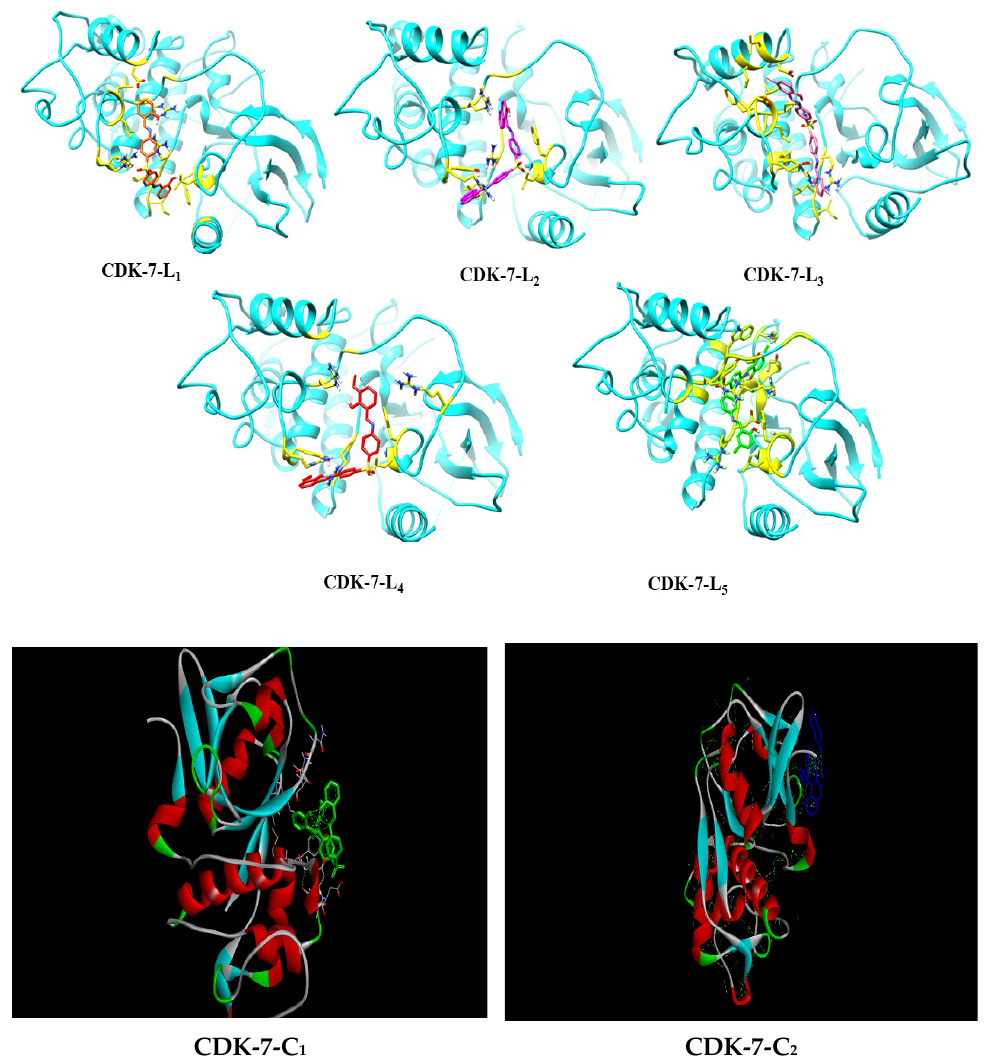
Figure 6. Binding interaction of Schiff base ligands (L 1 -L 5 ) (top) and Co(II) complexes (C 1 –C 2 ) with CDK-7 protein (bottom).